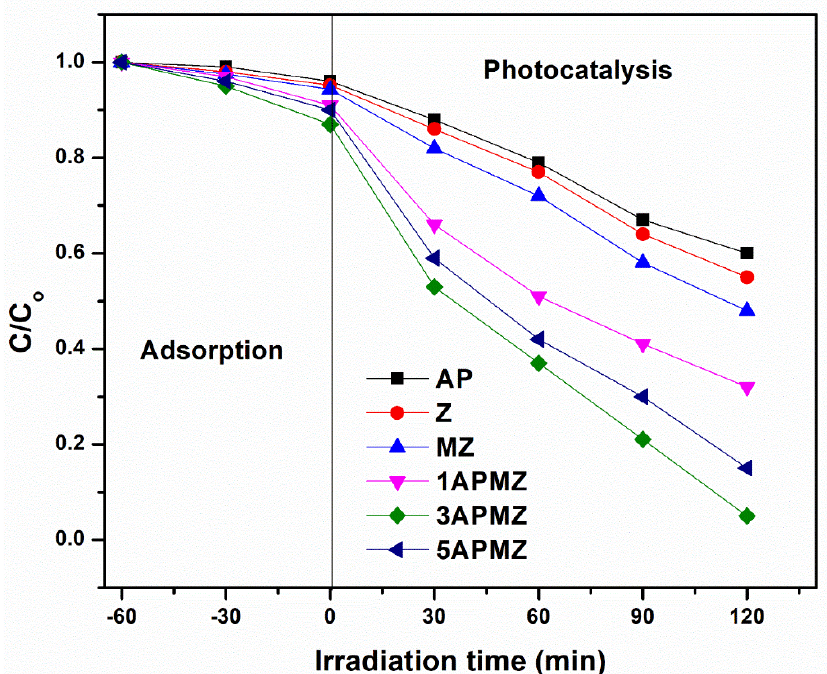
Figure 7. Photodegradation rate of tetracycline hydrochloride shown by Z, MZ, 1APMZ, 3APMZ, 5APMZ, and AP samples.